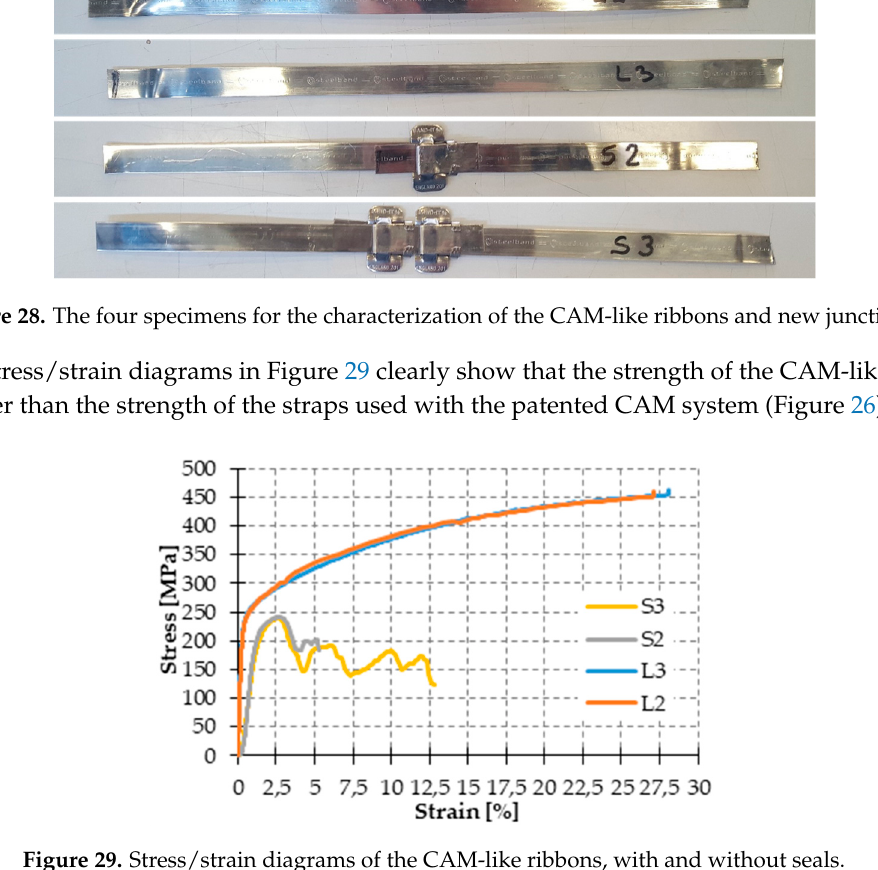
Figure 27. The seal used in the experimental program. Figure 28. The four specimens for the characterization of the CAM-like ribbons and new junctions.